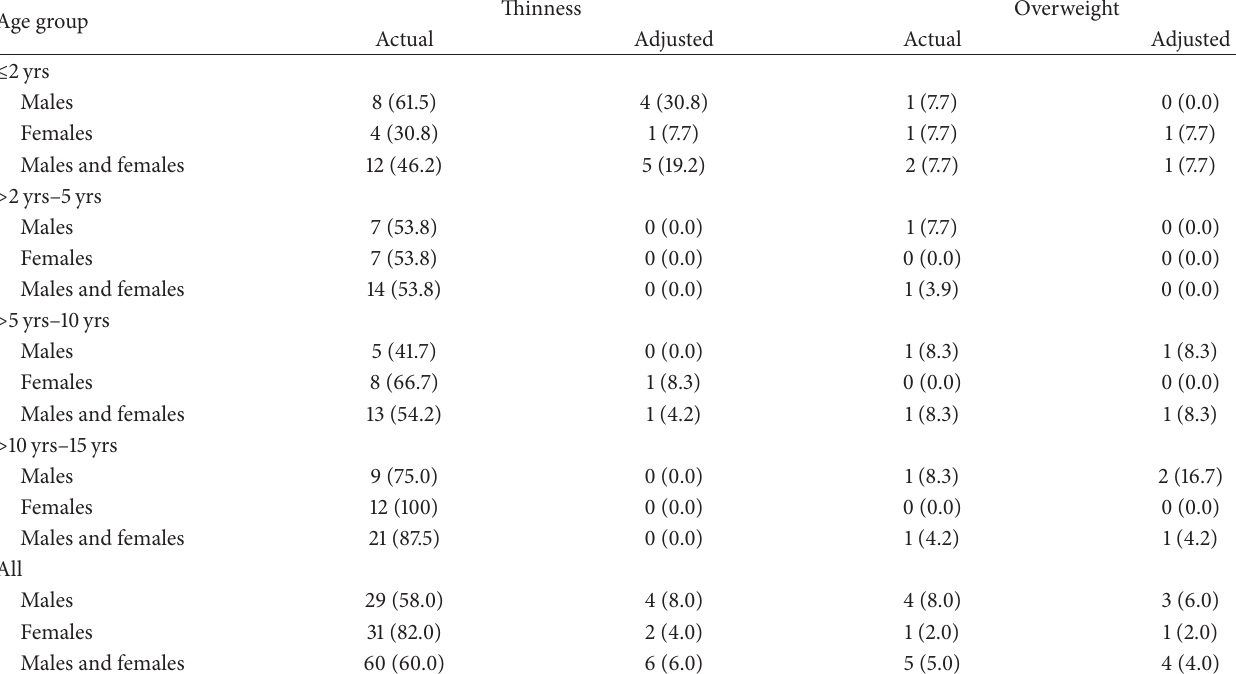
Table 5: The effect of adjusting the BMI of subjects with sickle cell anaemia for a mean Cormic Index of